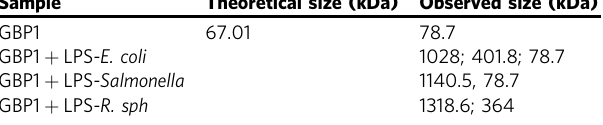
Table 1 Observed molecular weights of GBP1 peaks after incubation with various